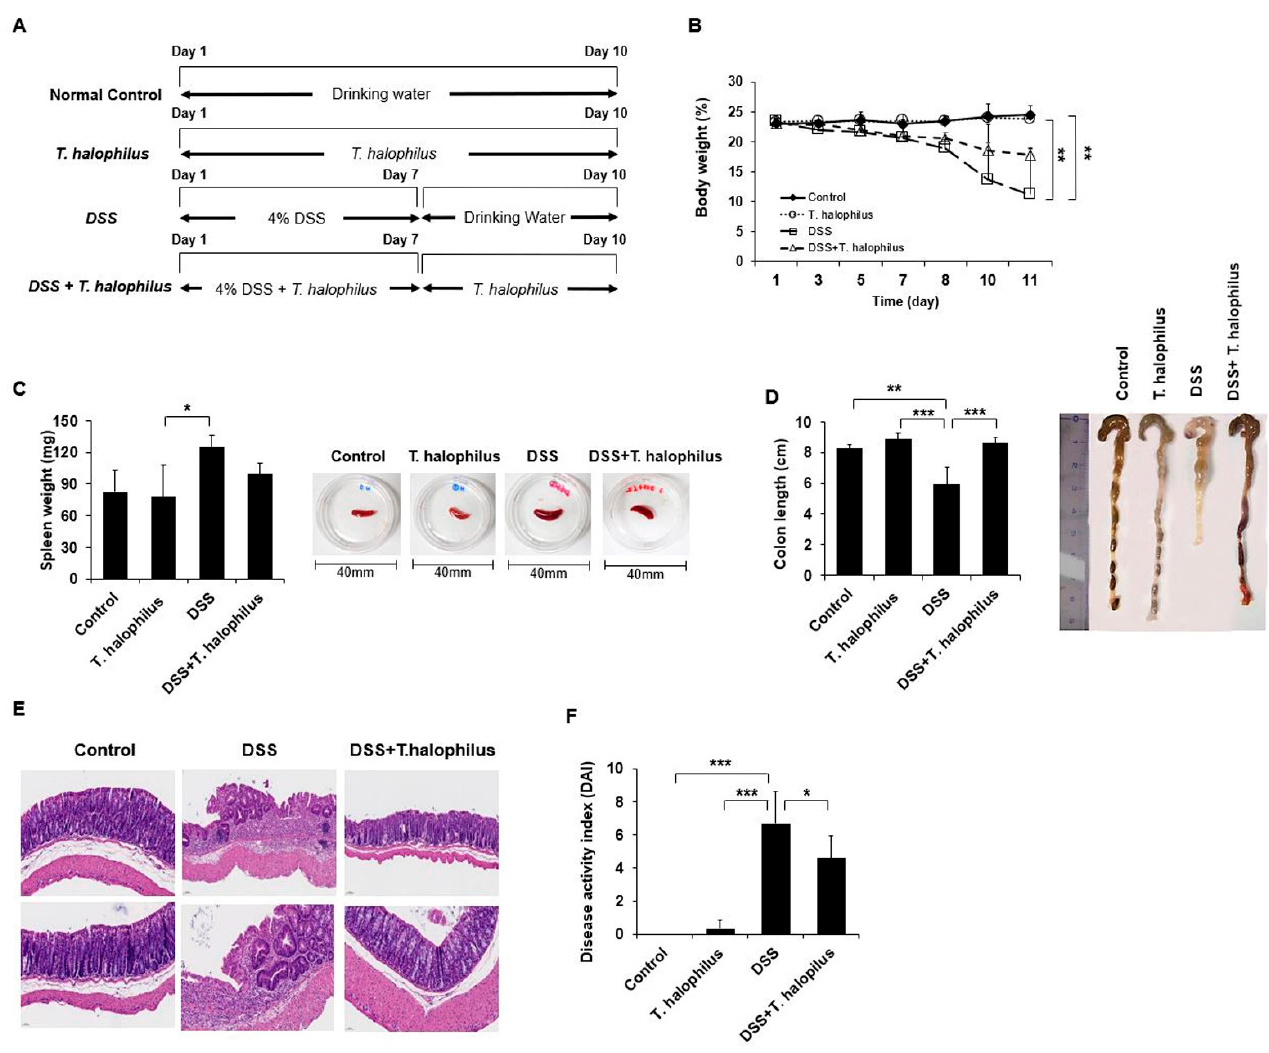
Figure 1. Effects of T. halophilus in DSS-induced colitis mice. ( A ) Schematic diagram of mice treatment and group distribution. ( B ) Effect of T. halophilus administration on weight change of mice after colitis induction. ( C ) Changes in spleen weights of mice after colitis induction. ( D ) Changes in colon lengths after administration of T. halophilus . ( E , F ) Colon histology and disease activity index (DAI) in mice with DSS-induced colitis after administration of T. halophilus . For statistical analysis, a one-way ANOVA followed by Bonferroni’s multiple comparison test was performed with GraphPad. The number of mice used for experiments was four in each group. Significantly different p -values are indicated by an asterisk as follows: *, p < 0.05; **, p < 0.01; ***, p < 0.001.